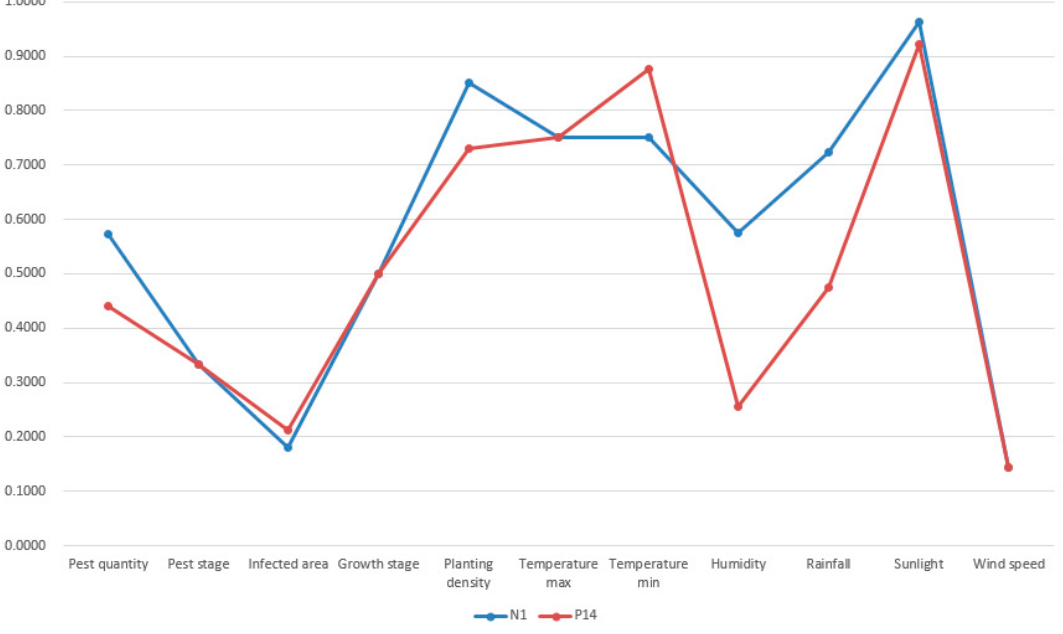
Figure 13. Visualization of the new case 1 and past case 148.